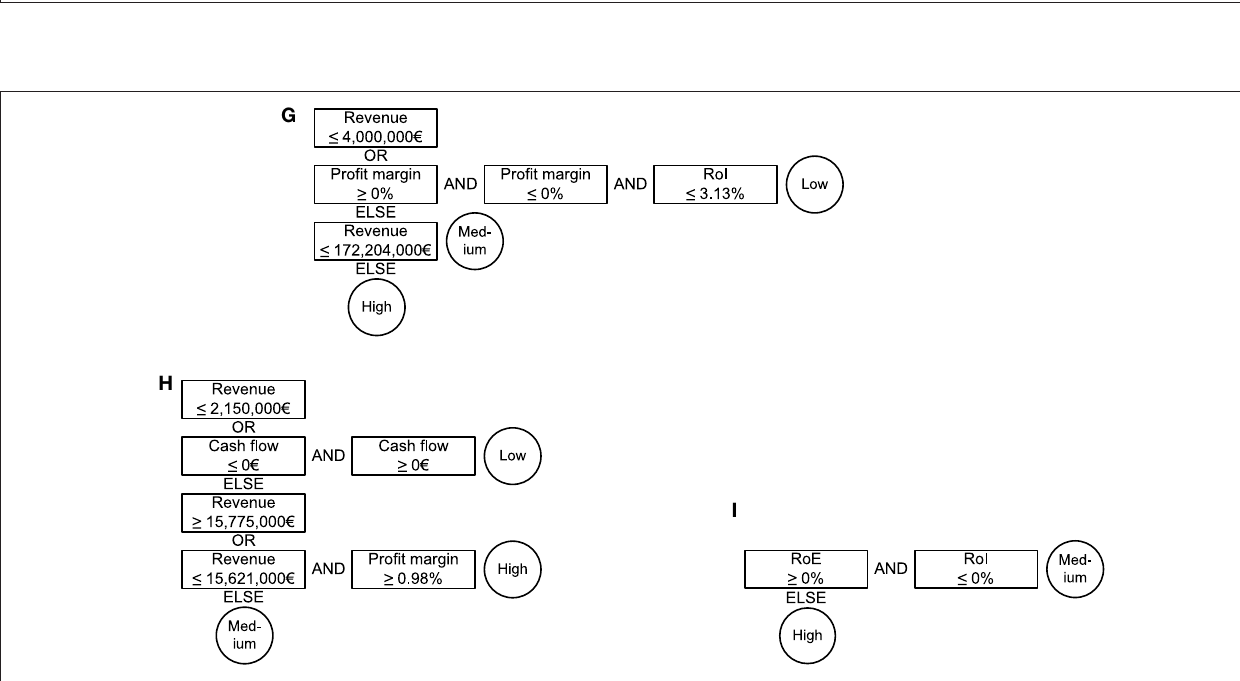
FIGURE 4 | Example models for DTs built on the three data sets. (D) Trade data set model. (E) Construction data set model. (F) Finance data set model.